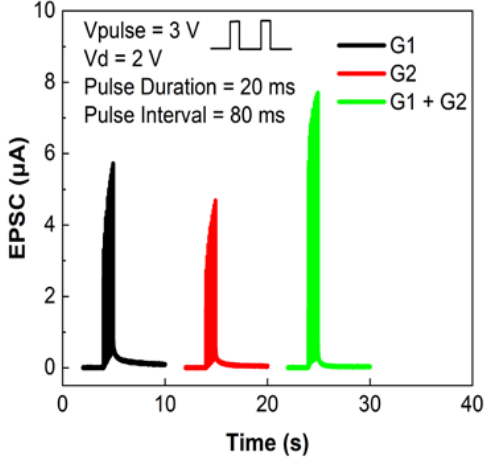
Figure 6. EPSCs controlled by consecutive pulses applied on G1 or G2, respectively, and G1 and G2, simultaneously.